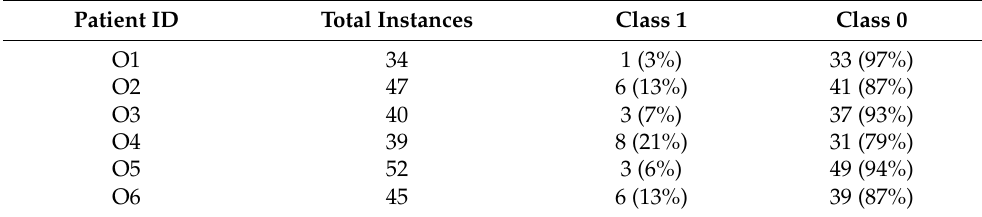
Table 2. Total number of instances for the six patients of the Ohio data set. Class 0 is defined as a sleep period without hypoglycemia and Class 1 is defined as a sleep period with hypoglycemia.